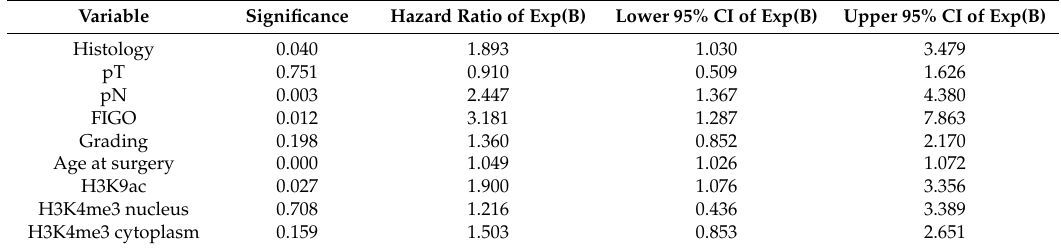
Table 3. Cox regression of clinic pathological variables regarding overall survival.